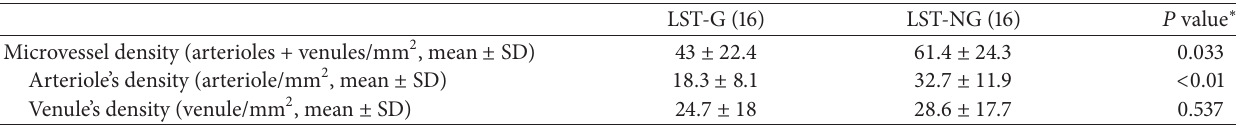
Table 4: Submucosal vascular density of laterally spreading tumor-granular (LST-G) and laterally spreading tumor-nongranular (LST-NG) types.